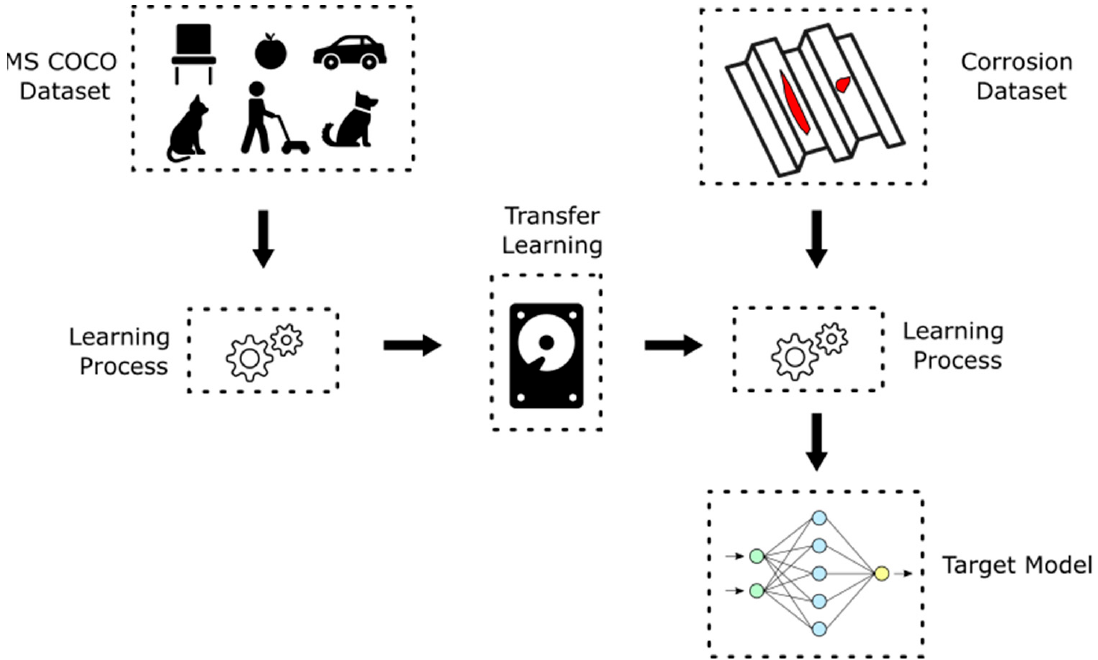
Figure 10. Adopted transfer learning